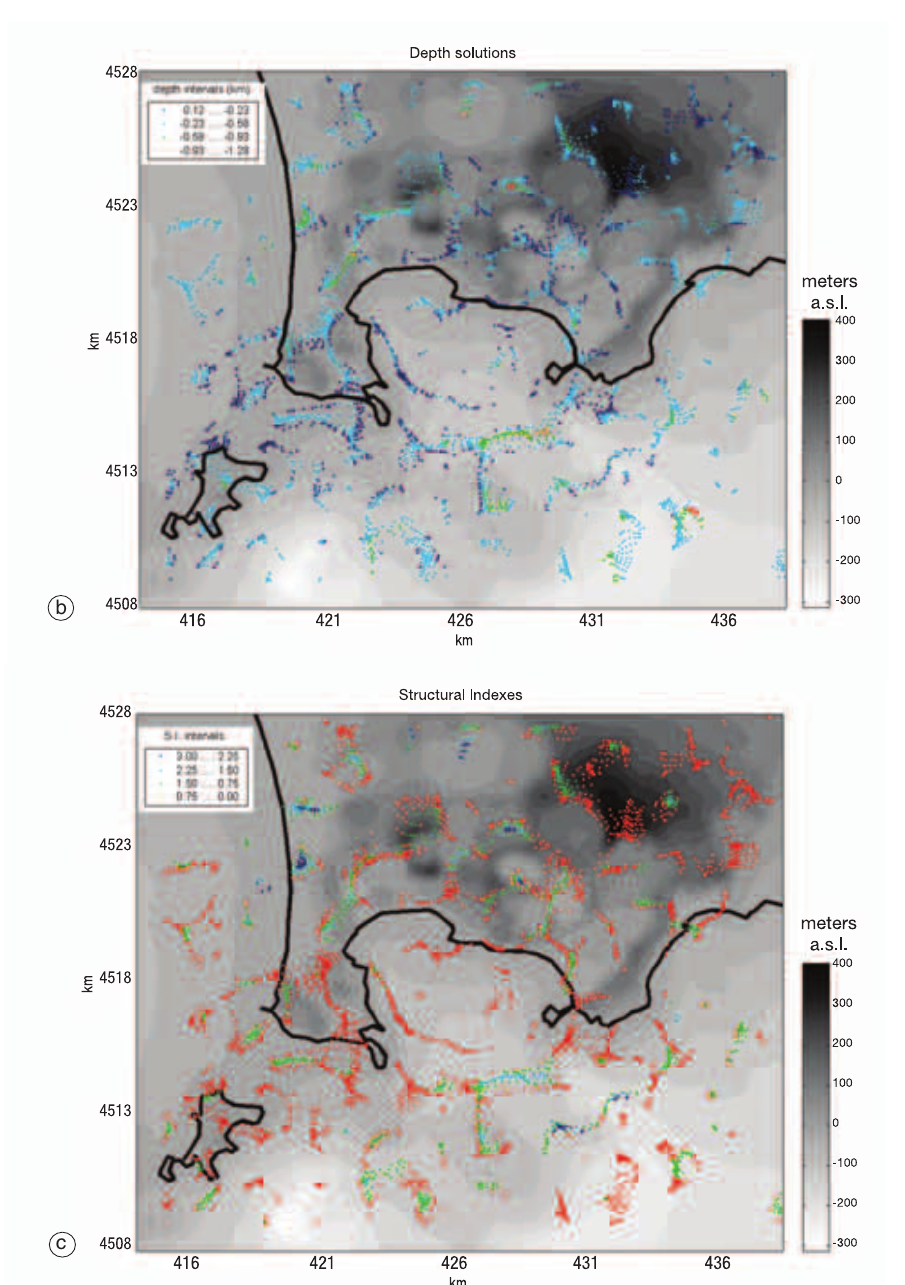
> – 1.28 km. Gray shading represents topography (darker colours = higher values). Coordinates UTM, zone